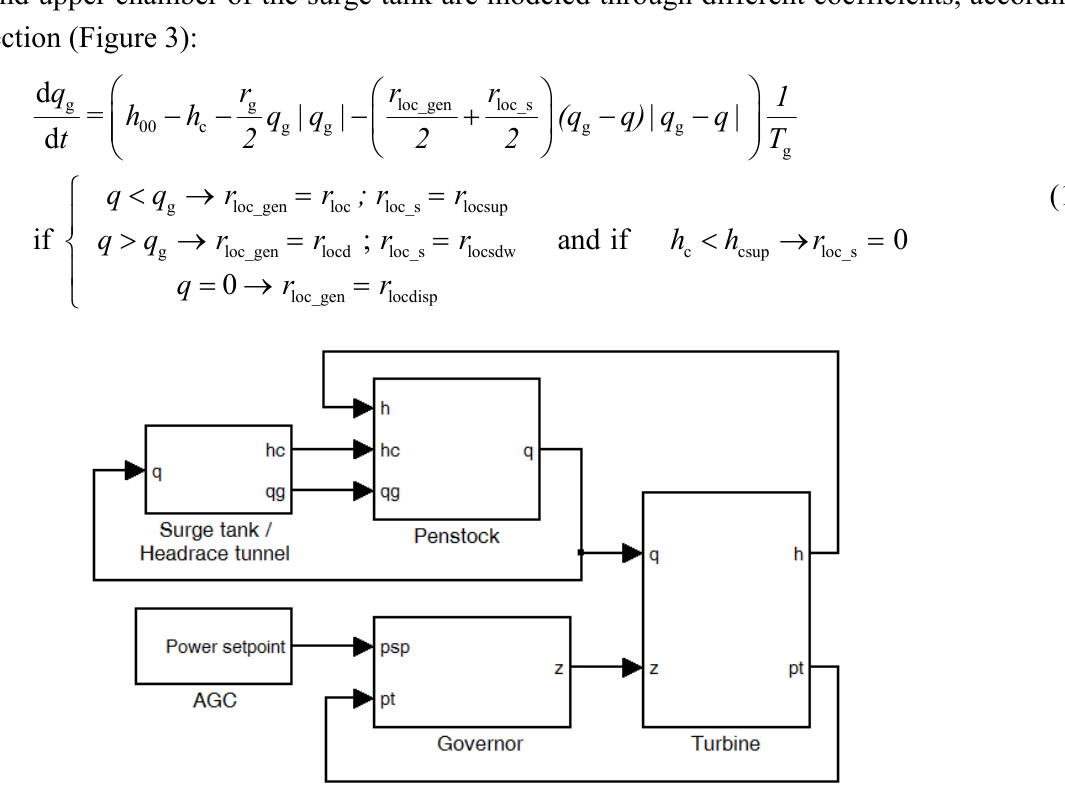
Figure 2. Block diagram of the simulation model. AGC: automatic generation control